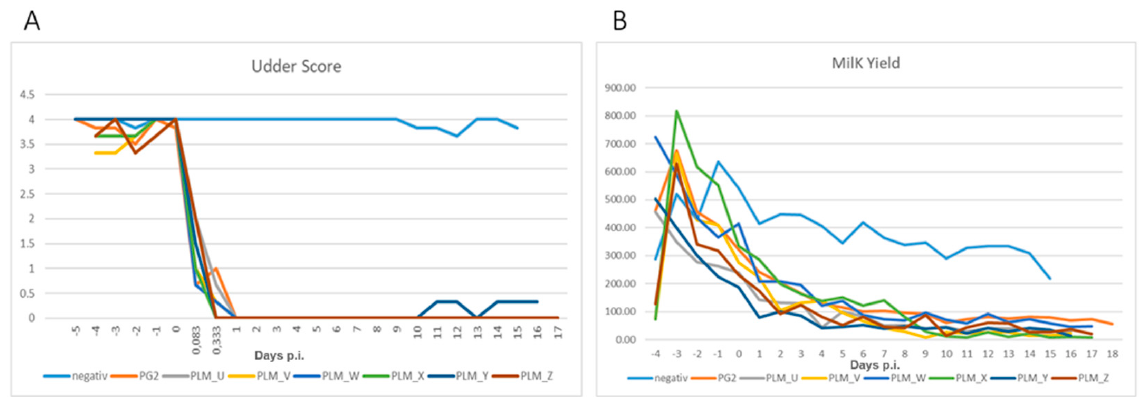
Figure 1. Average values of the udder scores ( A ) and milk yield in mL ( B ) for the eight infected groups of sheep over the test period.